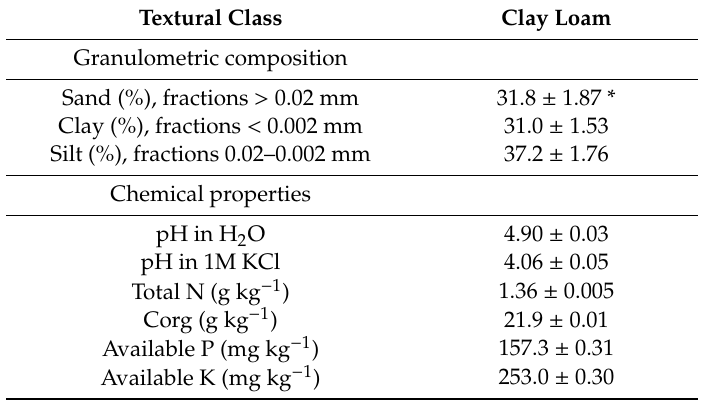
Table 1. Main chemical and physical properties of soil materials (average ± standard deviation value *).